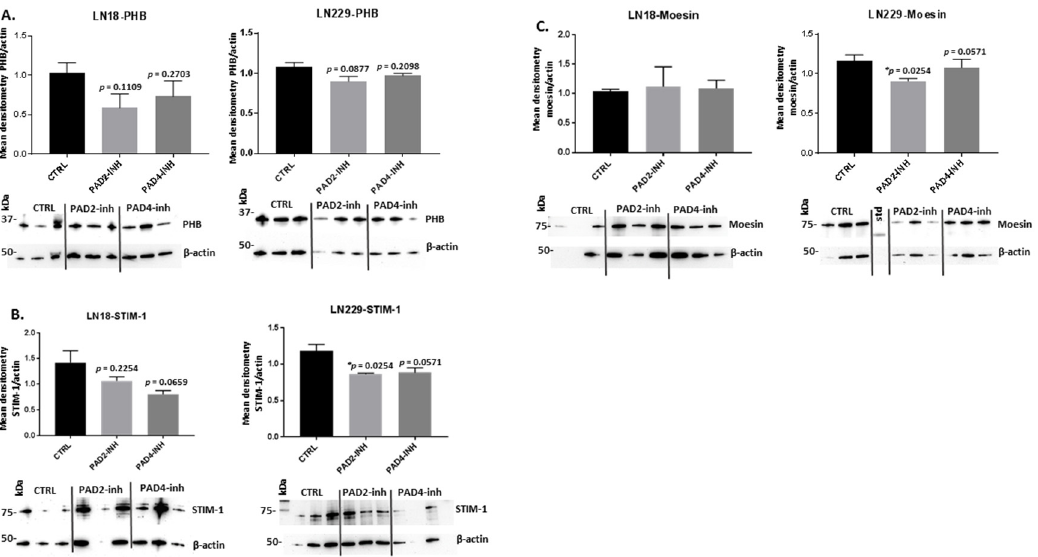
Figure 5. PAD2 and PAD4 isozyme-specific inhibitor 1 h treatment a ff ects prohibitin (PHB), stromal interaction molecule 1 (STIM-1) and moesin protein levels in LN18 and LN229 GBM cell lines. ( A ) PHB protein levels in LN18 and LN229 cells, respectively, following 1 h treatment with the PAD2 and PAD4 inhibitors, compared to control-treated cells. ( B ) STIM-1 protein levels in LN18 and LN229 cells respectively, following 1 h treatment with the PAD2 and PAD4 inhibitors, compared to control-treated cells. ( C ) Moesin protein levels in LN18 and LN229 cells, respectively, following 1 h treatment with the PAD2 and PAD4 inhibitors, compared to control-treated cells. Representative blots are shown; the density ratios of the various proteins analysed and actin are presented as normalised quantified data (mean ± S.D.) for treatment with the PAD2 and PAD4 specific inhibitors, compared to DMSO treated controls. The corresponding molecular weight size standard is indicated in kilodaltons (kDa) on each blot. Exact p -values are indicated, error bars show SD (* indicates significant di ff erences with p < 0.05; n = 3 biological replicates for all).